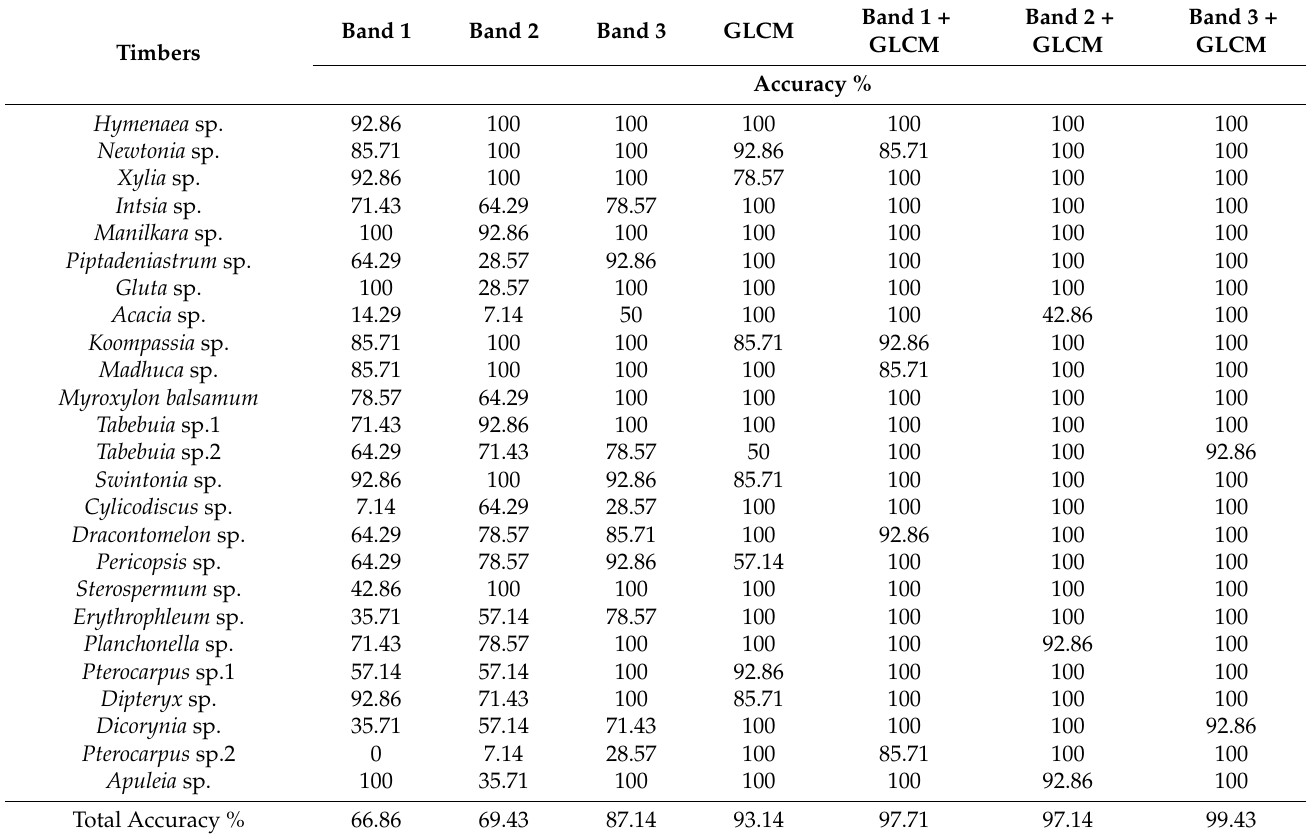
Table 3. Accuracy of identification based on the NIR, GLCM, and combined features.